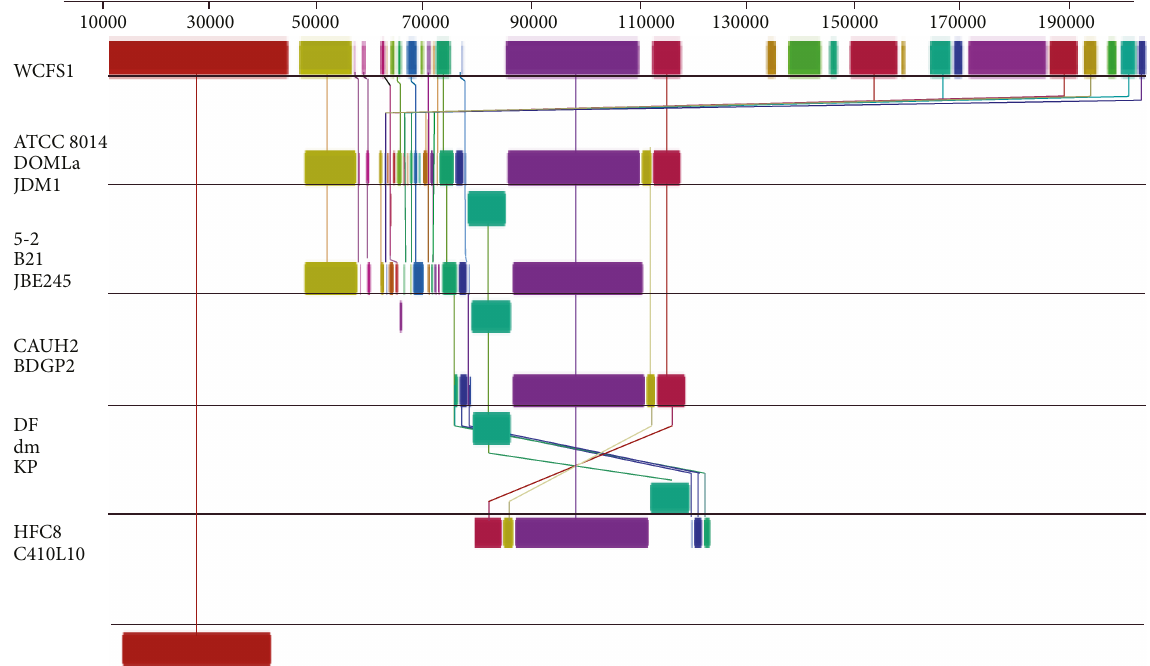
Figure 5: Comparative patterns of the lifestyle island in L. plantarum strains. The boxes below or above on the LCBs mean that the gene clusters are associated with obtaining energy. LCB weight value was 1000 bp. The region was analyzed corresponding to lp_3131 to lp_ 3661 of the L. plantarum WSFS1